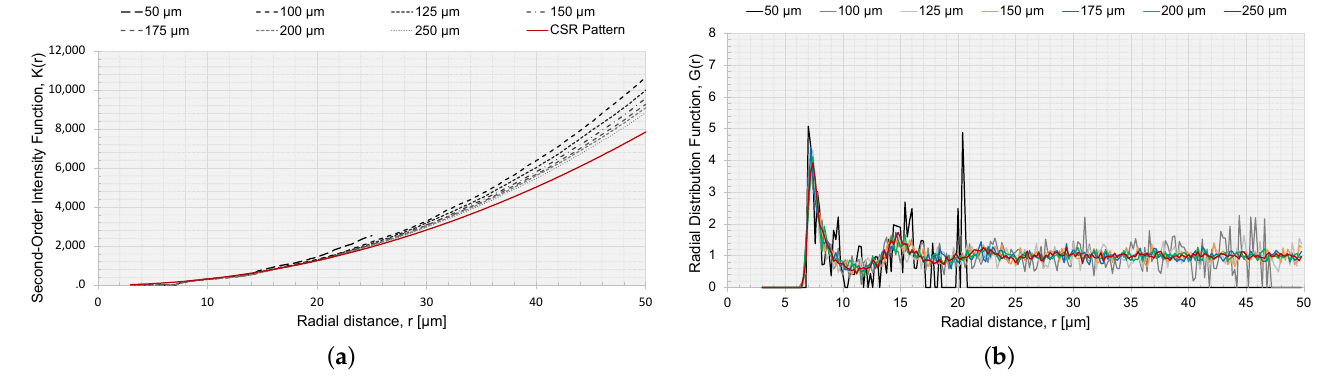
Figure 14. Second-order intensity function K ( r ) and the radial distribution function G ( r ) for different RVEs with side length L and no voids, ( a ) K ( r ) and ( b ) G ( r ) . The radial distribution function, Figures 13b,d,f and 14b, had a clear peak for all cases at approximately r = 7, which correlated to the first NN distance (Figure 9a). The fluctuations of the function converged to a unity of 1. The larger fluctuations were connected to the lower V f . Relating the first peak of the radial distribution and the height of the first peak to V f , a higher peak had a reduced V f . For the radial distribution function, the limitation was the size of the RVE, and the function would not converge to unity if the radial distance from a fiber was outside the observation area; therefore, when the radial distance was too large, it was no longer within the observation area, and the function G ( r ) became zero (Figure